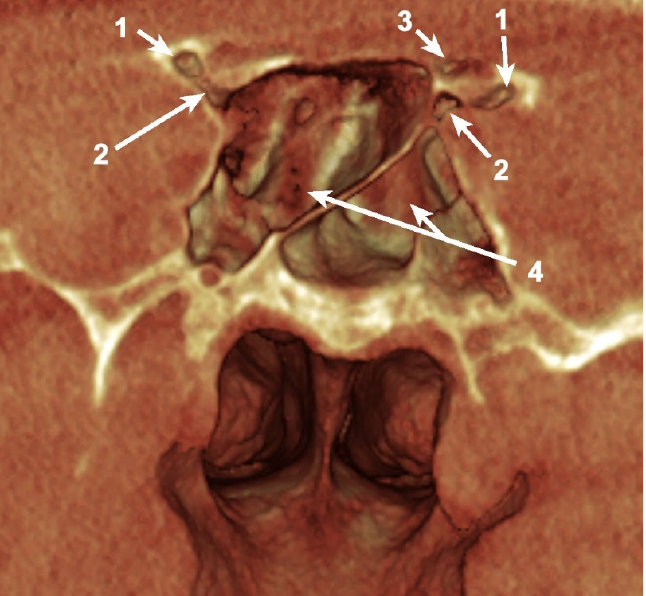
Figure 2. Coronal, bilateral three ‐ dimensional volume rendering of the anterior clinoid process (ACP) and sphenoid sinus, posterior view. 1. Pneumatized ACP; 2. Pneumatized optic strut; 3. Pneu ‐ matized anterior root; 4. Sphenoid sinus.